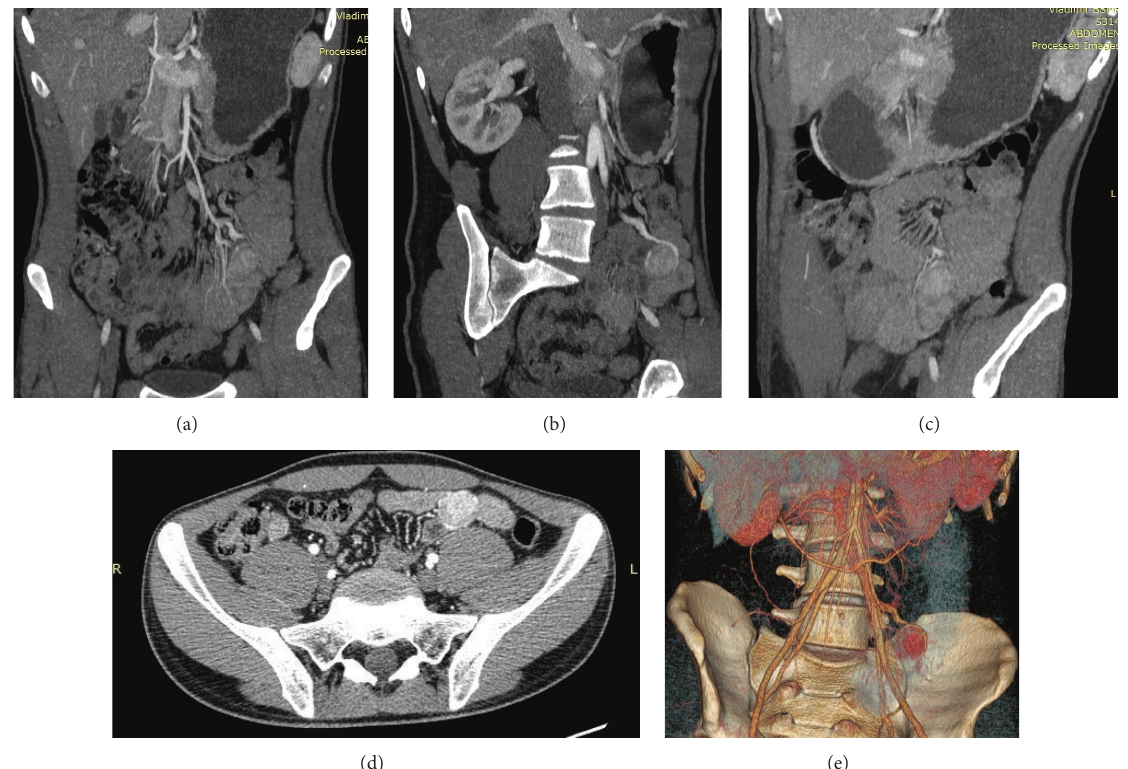
Figure 1: Contrast-enhanced CT showing highly vascular small bowel neoplasm: (a) coronal section, (b) and (c) oblique sections, (d) axial section, and (e) 3D reconstruction.